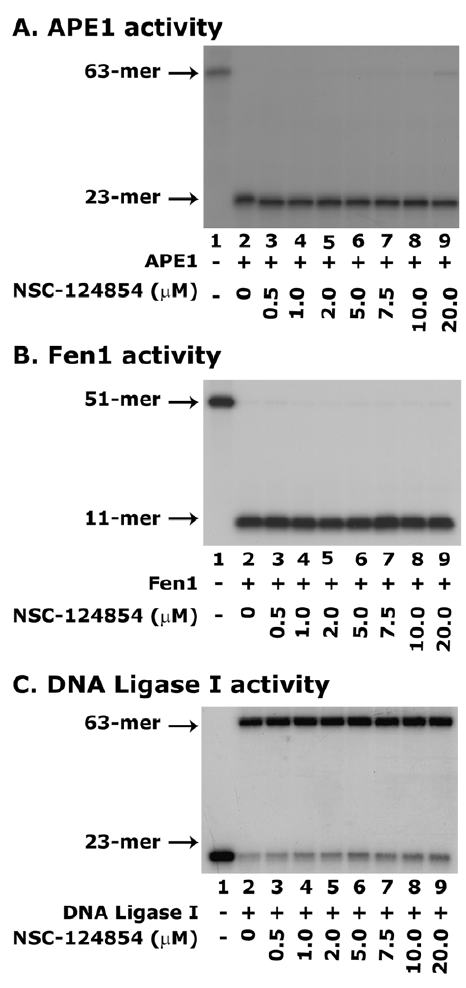
Figure 4. NSC-124854 does not block the activity of APE1, Fen1 and DNA ligase I in reconstituted invitro assays. Panel A shows the effect of NSC-124854 on APE1 activity. APE1 (10 nM) was incubated with different concentrations of NSC-124854 (0.5-20 m M, lanes 3-9, respectively) and 32 P-labeled 63-mer F-DNA. Lanes 1 and 2 show uncut 32 P-labeled 63-mer F-DNA and 23-mer incision product, respectively. Panel B shows the effect of NSC-124854 on Fen1 activity. Fen1 (10 nM) was incubated with different concentrations of NSC-124854 (0.5–20 m M, lanes 3–9, respectively) and 32 P-labeled 51-mer flapped-DNA. Lane 1 shows the position of 51-mer labeled oligonucleotide and lane 2 shows 11-mer cleaved flap product. Panel C shows the effect of NSC-124854 on DNA ligase I activity. DNA ligase I (5 nM) was incubated with different concentrations of NSC-124854 (0.5–20 m M, lanes 3–9, respec- tively) followed by addition of 2.5 nM of 32 P-labeled 63-mer nicked DNA. Lane 1 shows 23-mer labeled oligonucleotide (nicked product) and lane 2 shows 63-mer ligated product. Data are representative of two independent experiments.